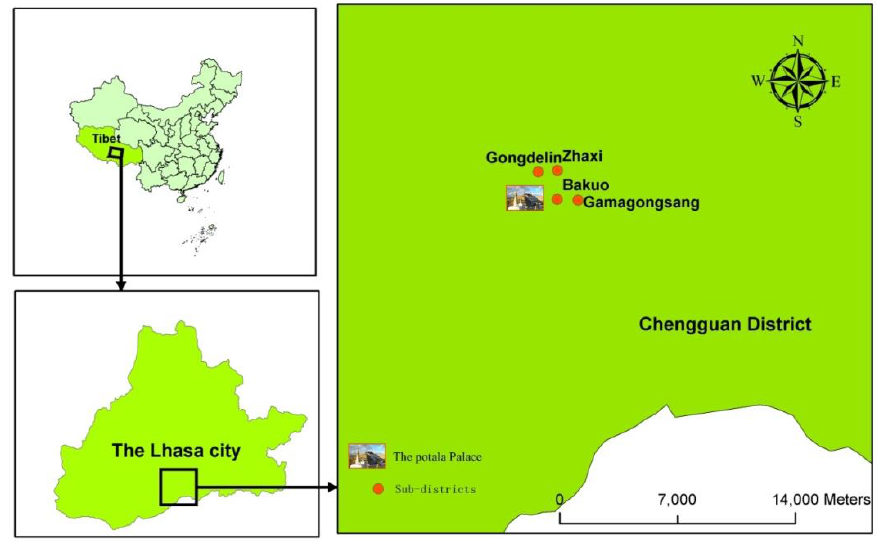
Figure 1. The four urban sub-districts of this